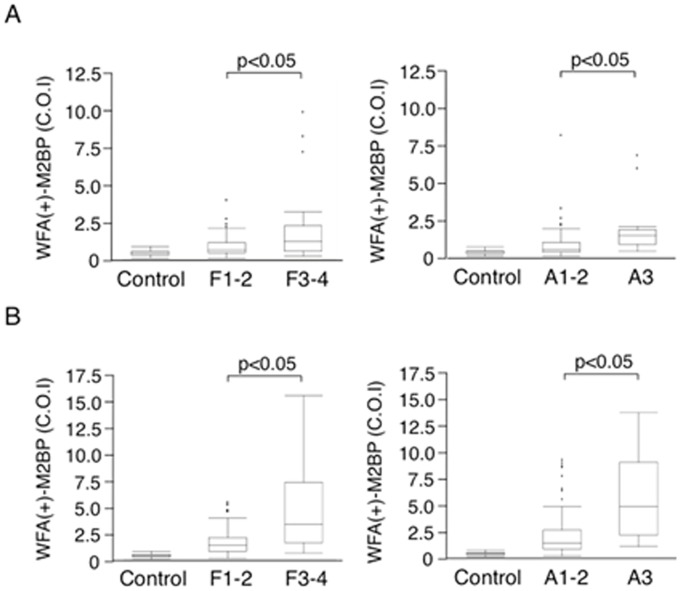
Serum WFA(+)-M2BP levels in the patients with HBV (A) or HCV infection (B).Liver fibrosis staging: F1, fibrous expansion of portal area; F2, fibrous expansion of portal area with portal-to-portal bridging fibrosis; F3, marked bridging fibrosis with occasional nodules; or F4, cirrhosis. Grading of the activity of liver inflammation: A1, mild; A2, moderate; or A3, severe [21,22].